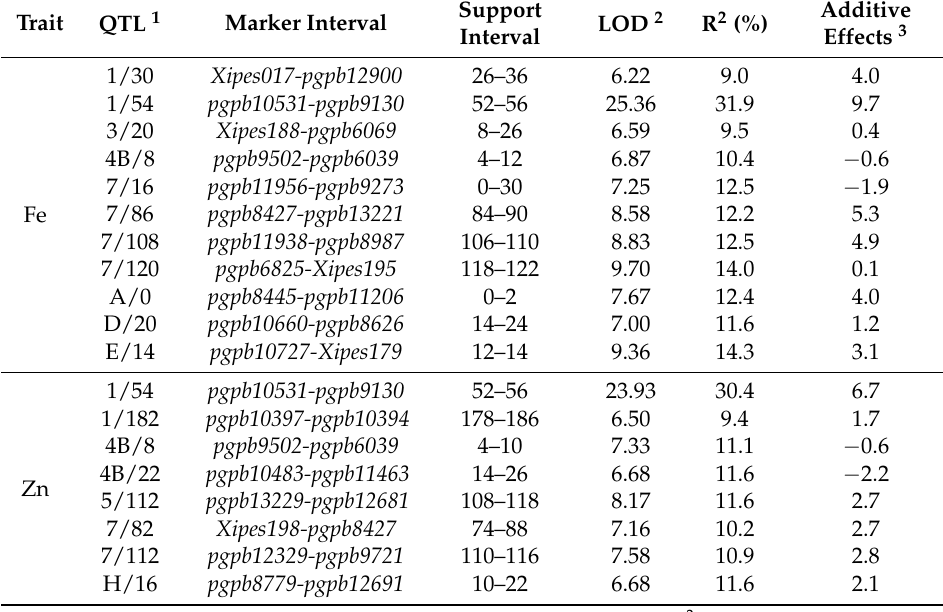
Table 4. Positions and descriptions of QTLs affecting various traits in the (ICMS 8511-deriv ×